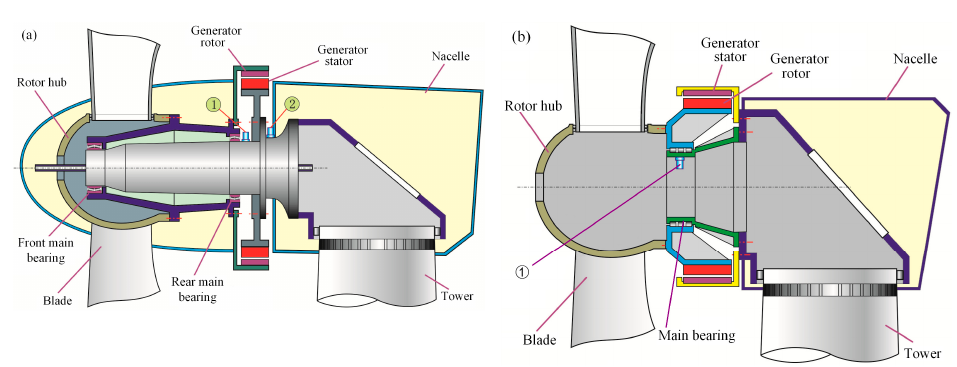
Figure 2. Drivetrains of direct-drive wind turbine: ( a ) external rotor; ( b ) internal rotor.